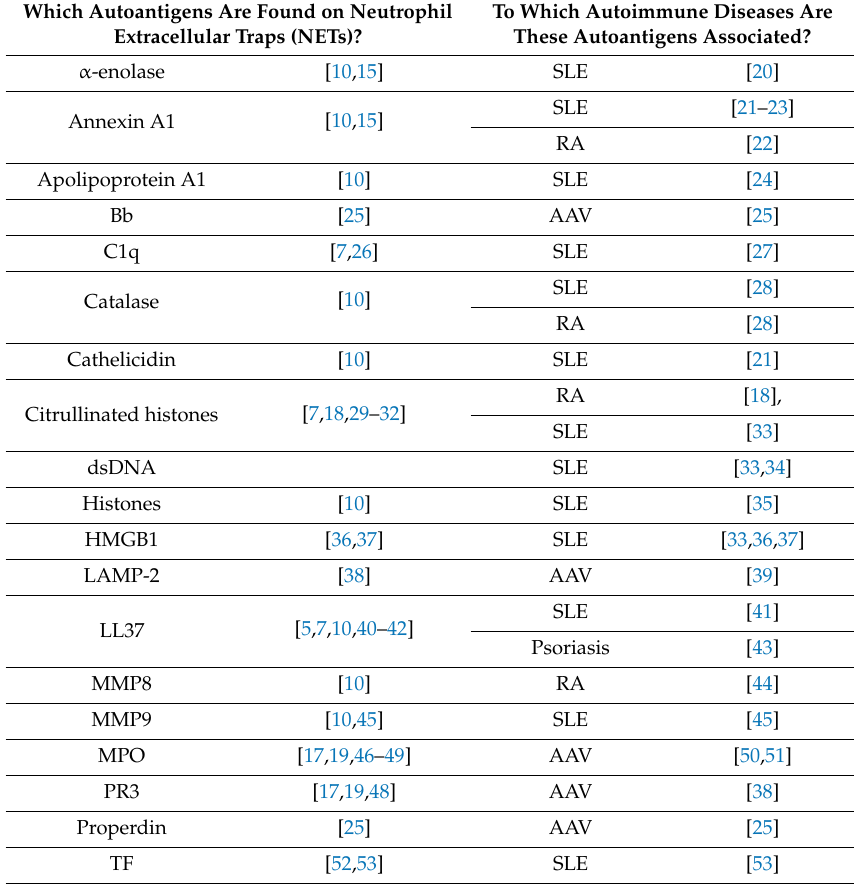
Table 1. Neutrophil extracellular traps (NETs)-associated molecules that are known autoantigens in various autoimmune diseases. Which Autoantigens Are Found on Neutrophil To Which Autoimmune Diseases Are Extracellular Traps (NETs)? These Autoantigens